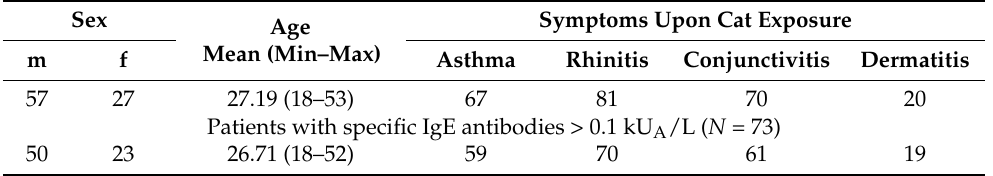
Figure 1. Consort diagram of the enrolment of patients. Table 1. Demographic and clinical characteristics of patients with clinical symptoms of cat allergy (asthma, rhinitis, conjunctivitis, and dermatitis) (upper part) and of patients with cat allergen-specific IgE antibodies (lower